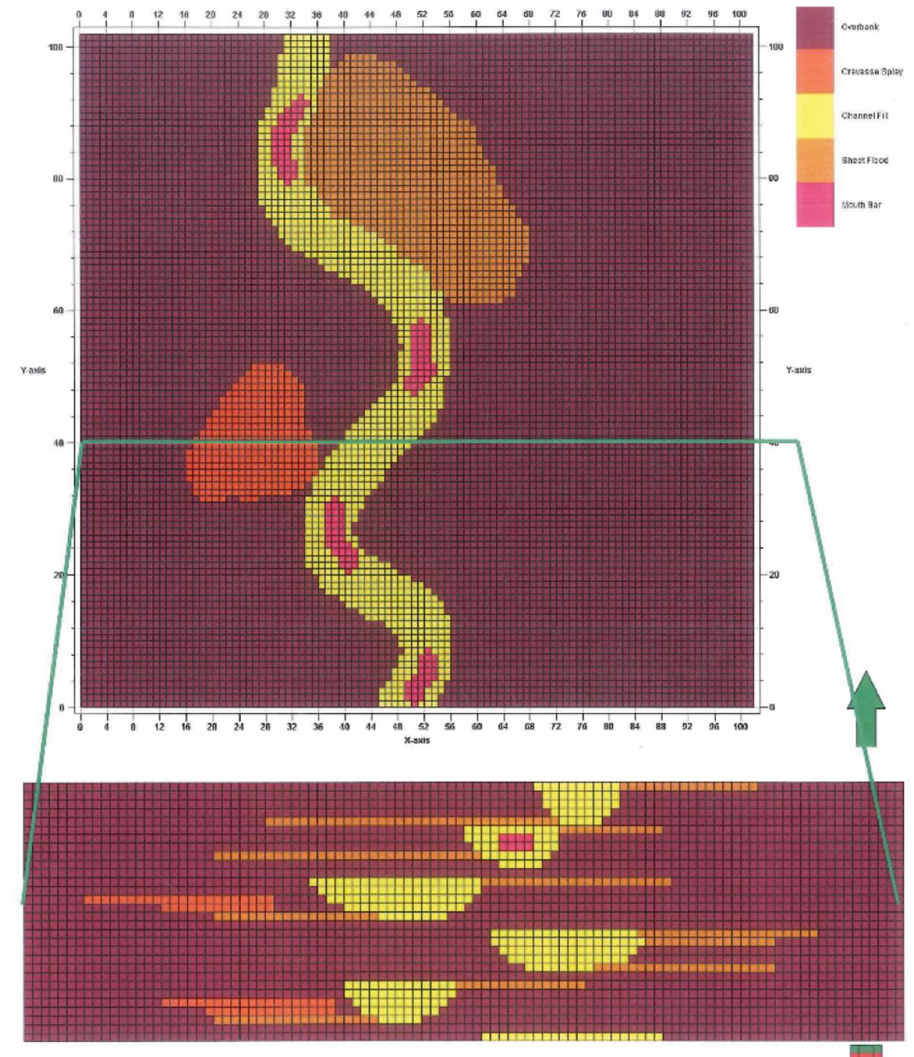
Fig. 15 Training image for river area in cross horizontal and vertical